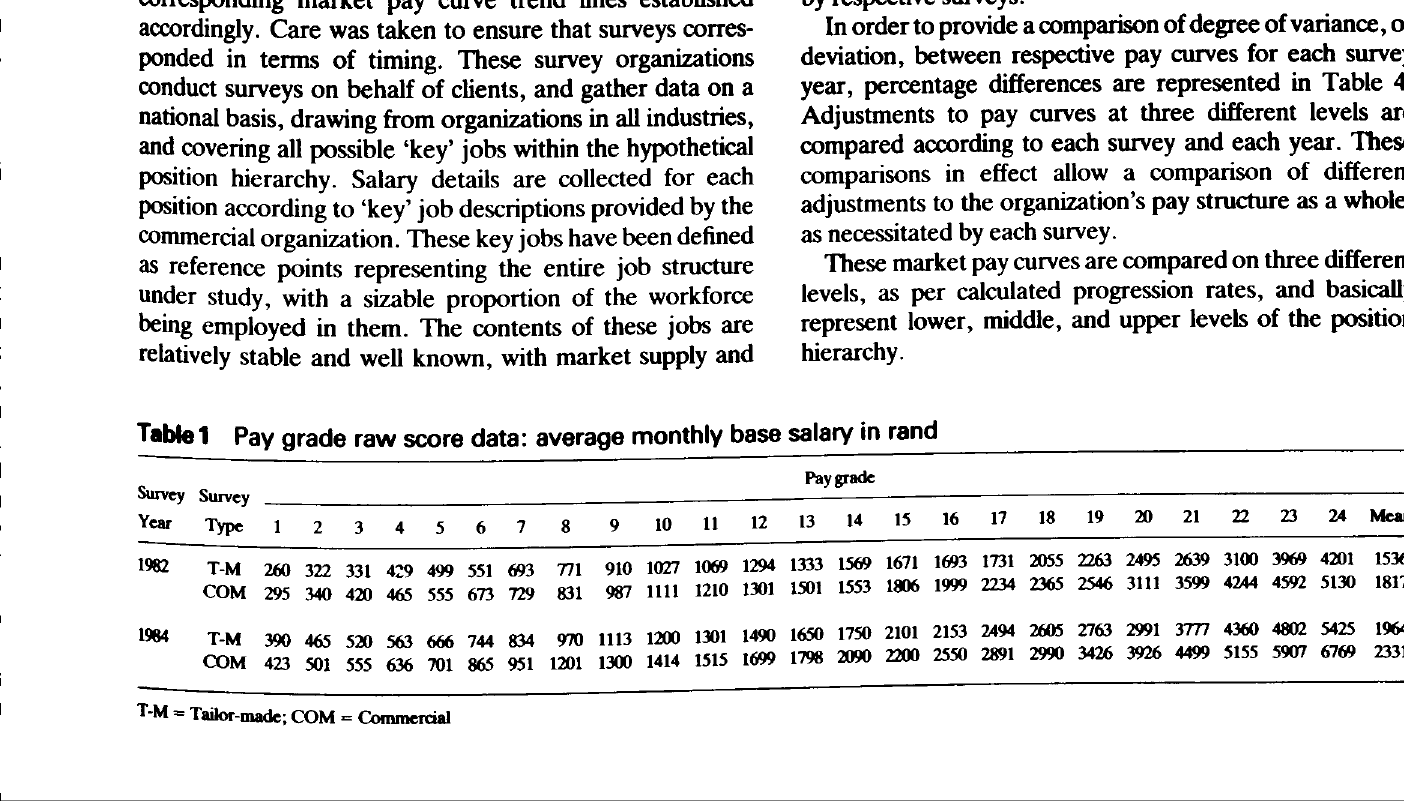
Table 1 Pay grade raw score data: average monthly base salary in rand Survey Survey Year